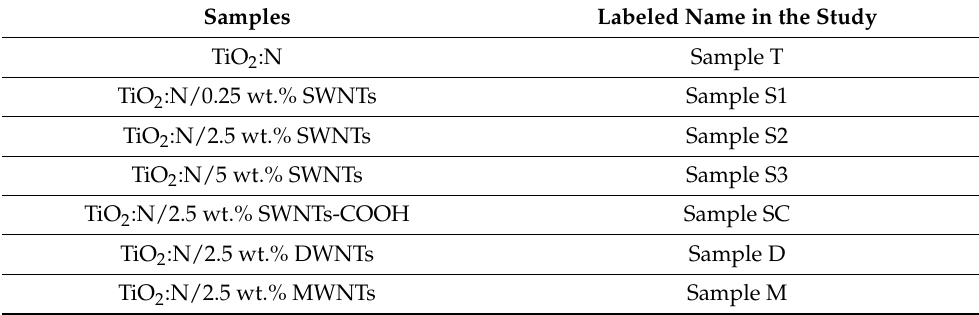
Table 1. Short names of the samples used in the